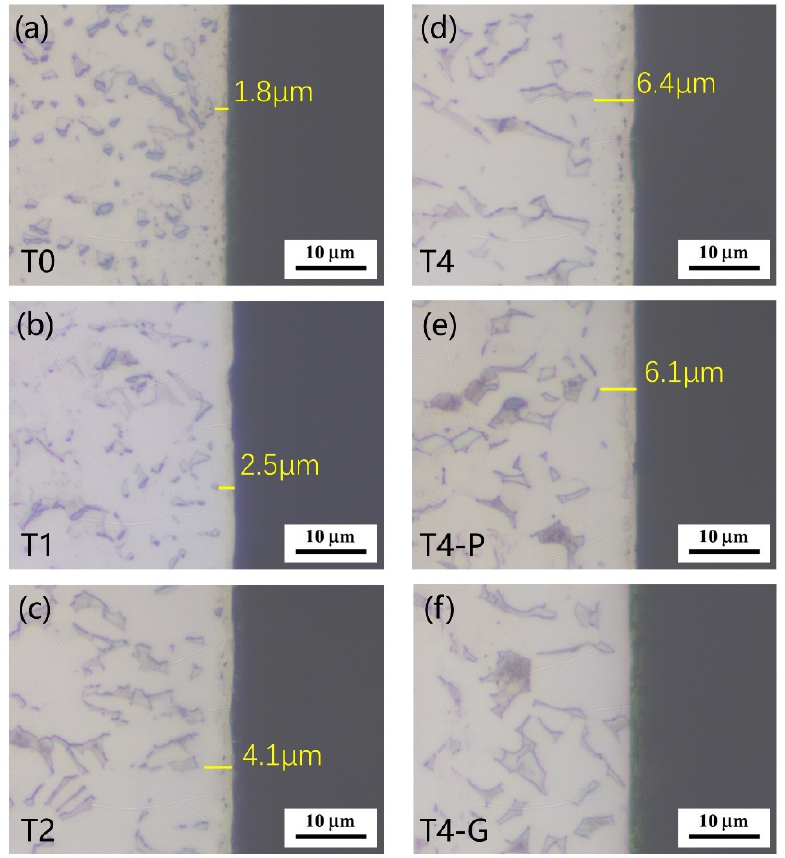
Figure 3. The cross-sectional optical micrographs of different samples.